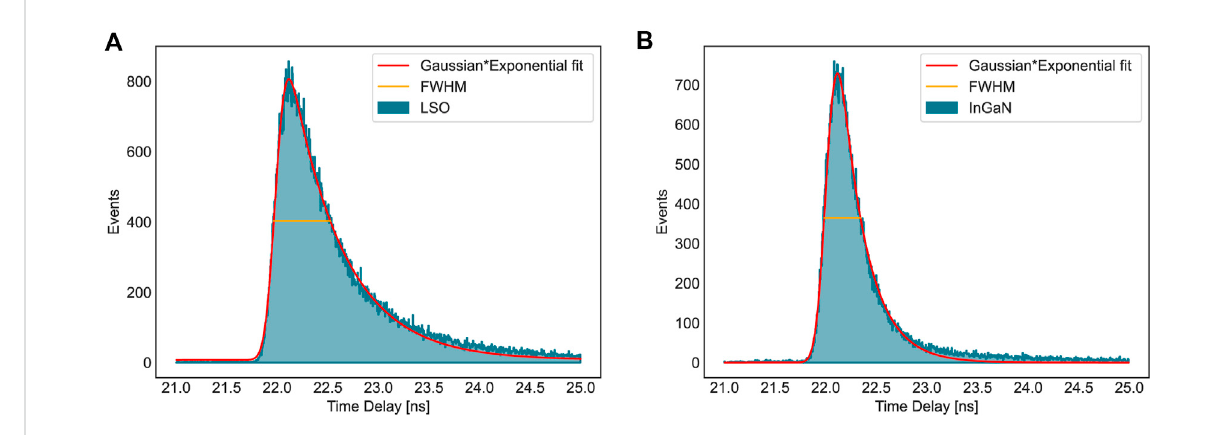
FIGURE 2 Time delay distribution of LSO (A) and InGaN (B) fi tted with the convolution between Gaussian and exponential functions to extrapolate the FWHM.